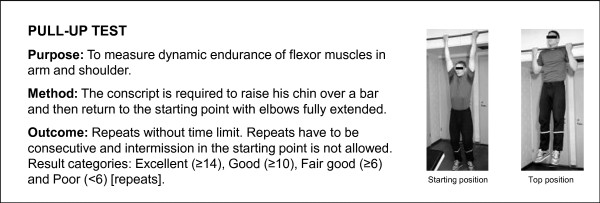
Description of pull-up test. The test is based on practice in the Finnish Defence Forces.